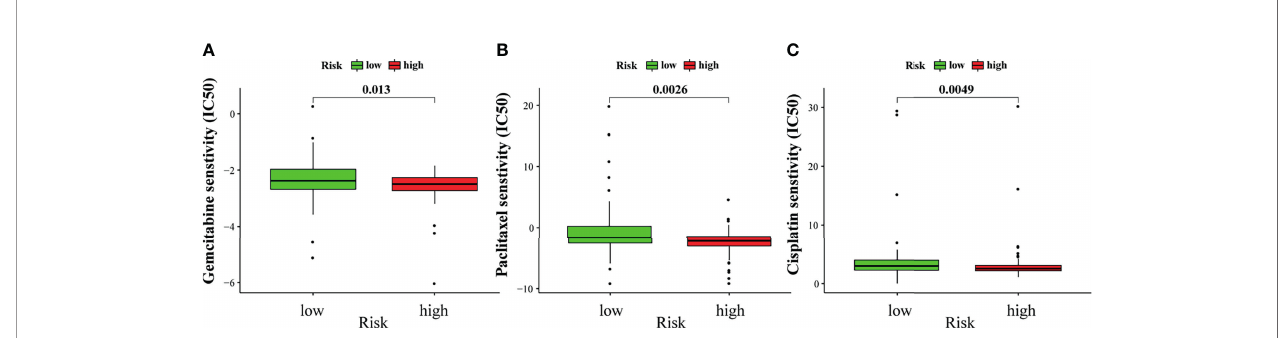
FIGURE 10 | Sensitivity to chemotherapy in high-risk and low-risk groups. The high-risk group was related to a lower IC50 for gemcitabine (A) , paclitaxel (B) , and cisplatin (C)